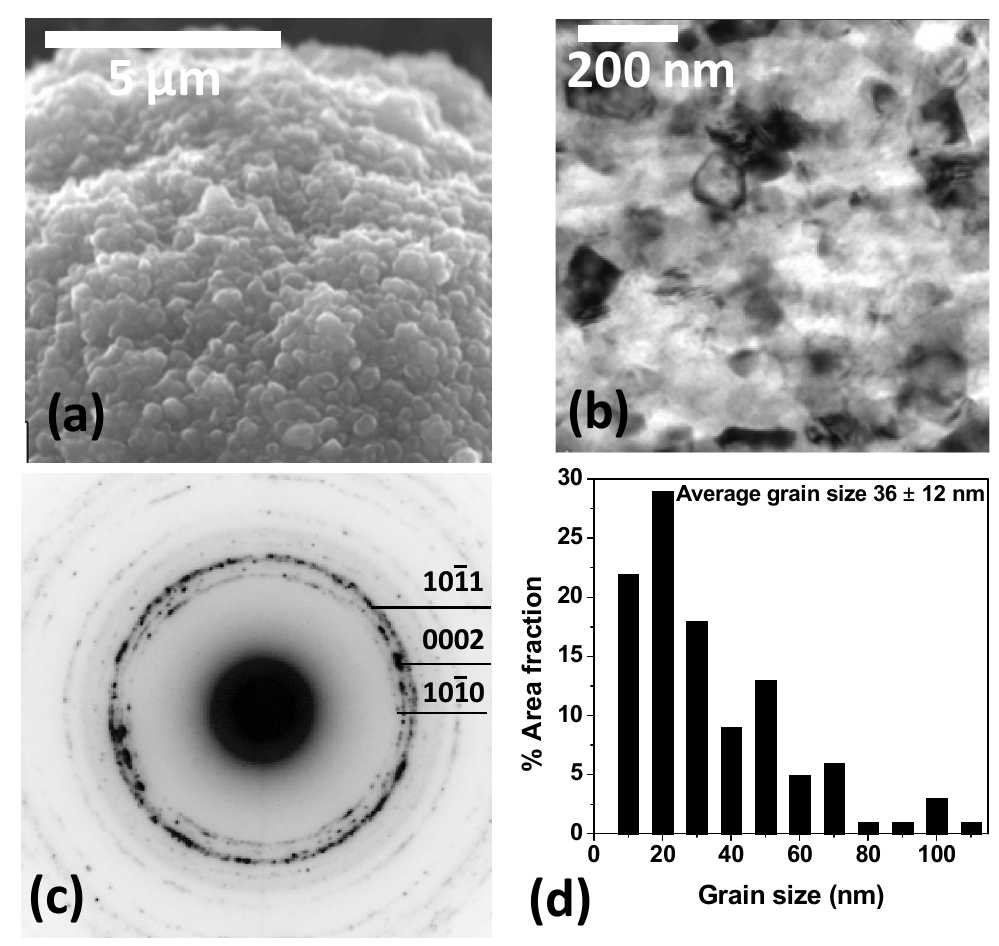
Figure 6. ( a ) SEM image of rough globular morphology; ( b ) Bright Field TEM image of rough globular morphology; ( c ) selected area electron diffraction pattern indicating presence of hcp–Mg(Al) phase; ( d ) grain size